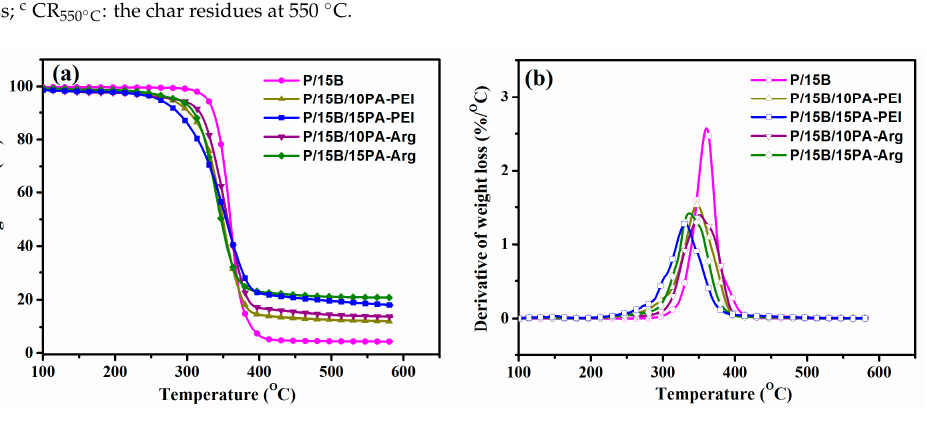
Figure 3. ( a ) TGA and ( b ) DTG curves of the P/15B-based bicomposites at a heating rate of 10 °C min − 1 under N 2 . Table 3. TGA and DTG data of PLA/PBS-based bicomposites under N 2 atmosphere.